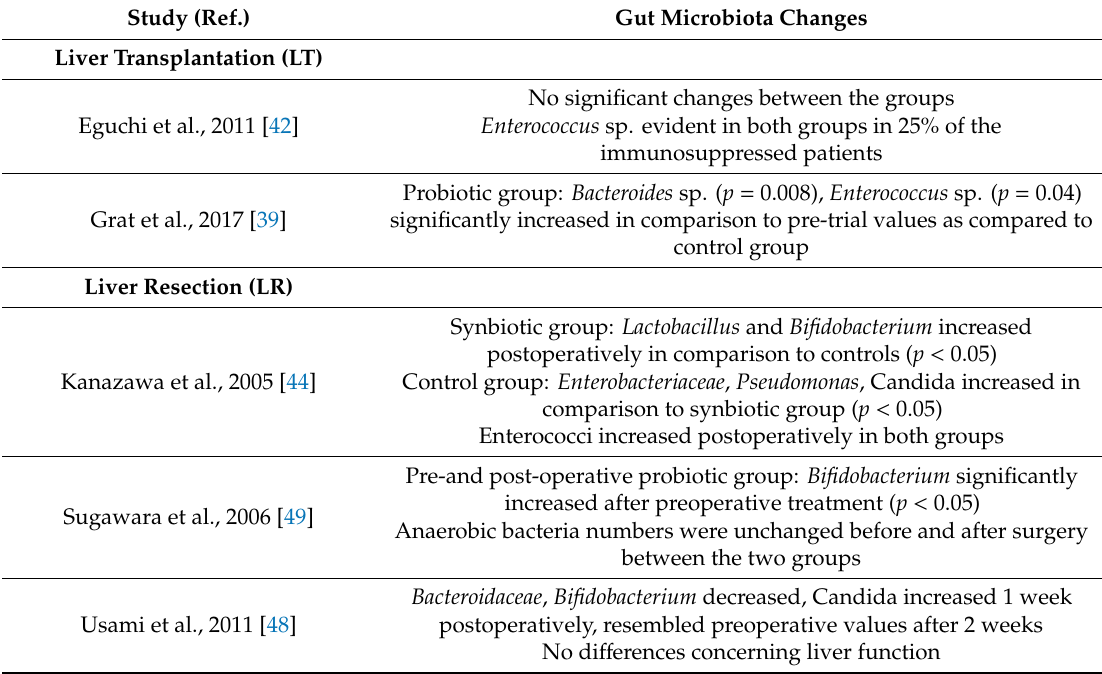
Table 3. Studies on perioperative pro- / synbiotics and their e ff ect on changes of the gut microbiota. Study